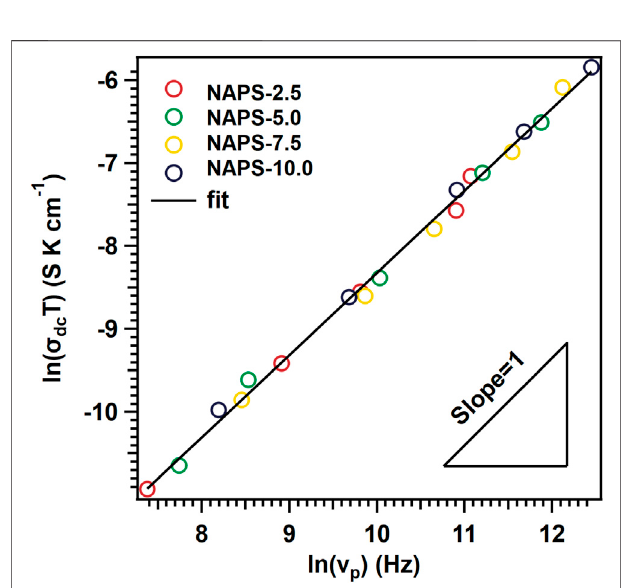
Frontiers in Materials |